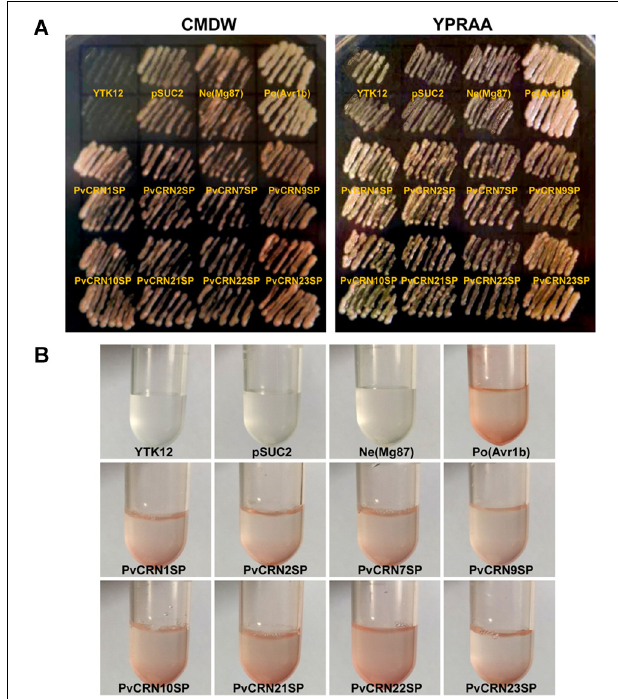
FIGURE 3 | Functional validation of the predicted signal peptides of the PvCRN proteins. (A) Yeast growth assay on CMD-W media (left) and YPRAA media (right). (B) Yeast invertase secretion assay for the predicted signal peptides of the indicated PvCRN